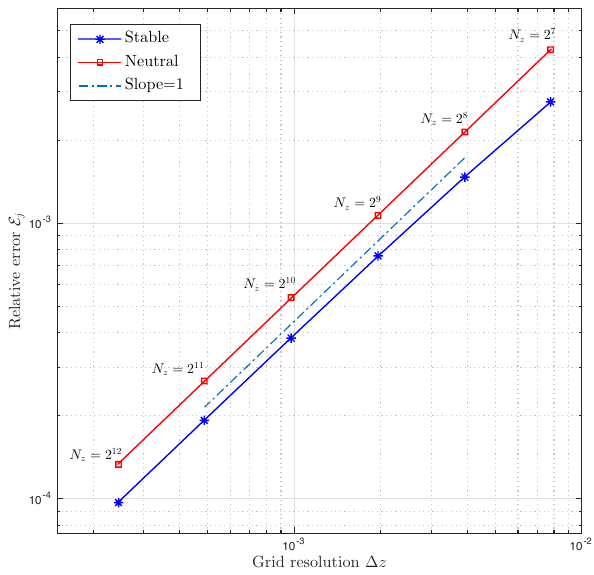
Figure 2. Relative error E j (see Eq. 18) of the FPE solutions as a function of grid resolution (cid:49)z = 2 − j for j = 7 , 8 ,..., 12 for the two test-case problems. Stars: stable ABL ( E j (t = h/u ∗ ) ). Squares: neutral ABL ( E j (t = 3 h/u ∗ )